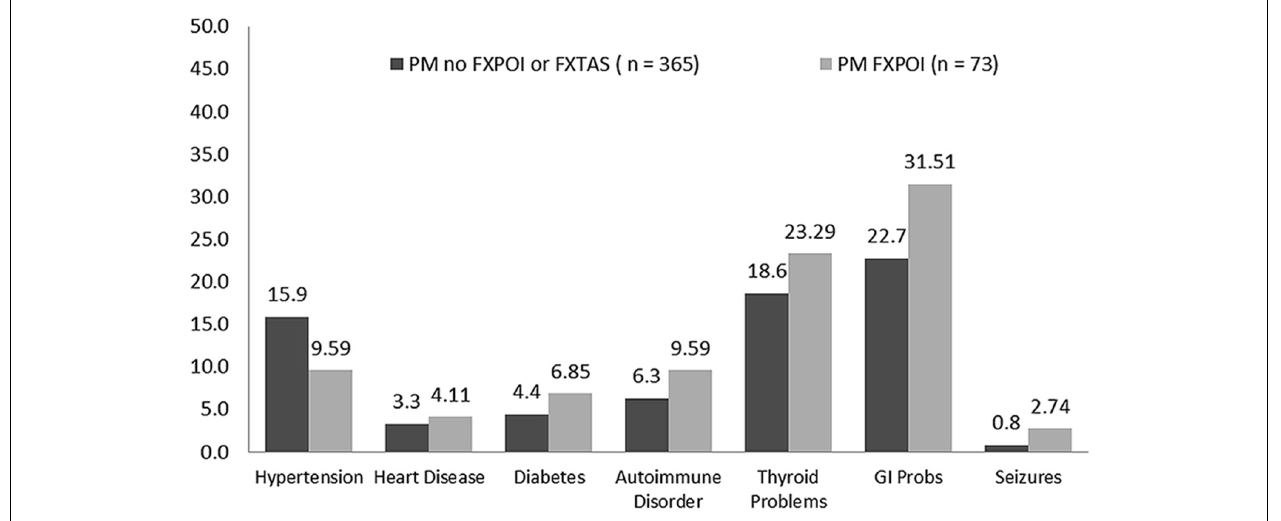
FIGURE 3 | Percentage of women with and without FXPOI endorsing co-occurring medical conditions.